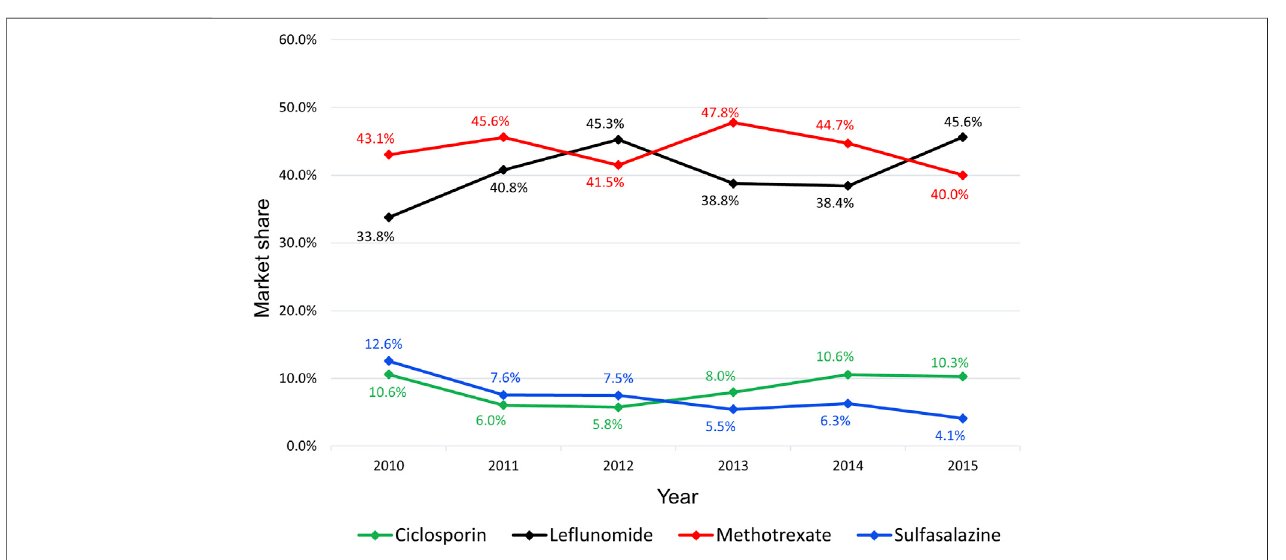
FIGURE 1 | Market share of csDMARD for psoriatic arthritis from 2010 to 2015.